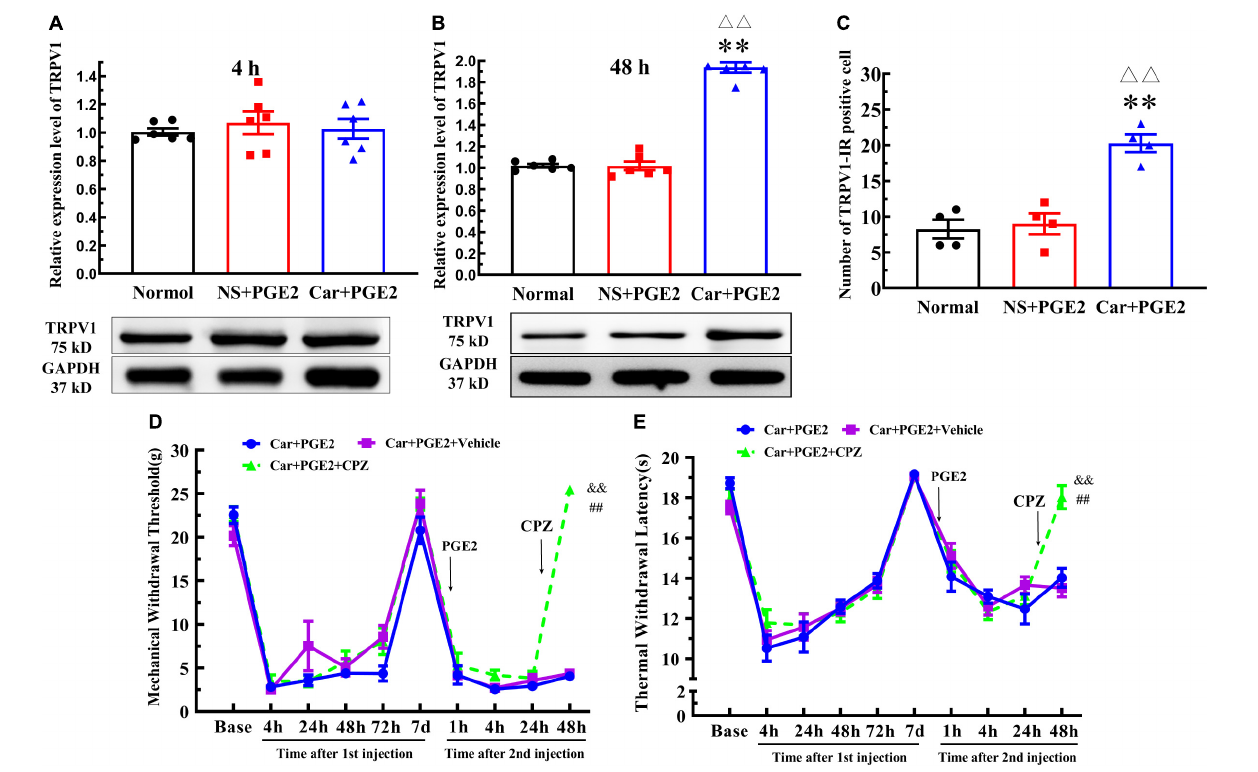
FIGURE 3 | Transient receptor potential vanilloid 1 (TRPV1) in the DRG contributed to the chronic mechanical and thermal pain induced by carrageenan and PGE2 injections. (A) The quantification of the Western blot results and a representative Western blot showing TRPV1 protein isolated from the DRG 4 h after PGE2 injection. (B) The quantification of the Western blot results and a representative Western blot showing TRPV1 protein isolated from the DRG 48 h after PGE2 injection. (C) The quantification of TRPV1–IR positive neurons. Mechanical (D) and thermal (E) responses of hyperalgesia model animals that received capsazepine (CPZ) injection. n = 6. **Compared with the normal group, P < 0.01; (cid:52)(cid:52) compared with the NS+PGE2 group, P < 0.01; ## compared with the Car+PGE2 group, P < 0.01; && compared with the Car+PGE2+vehicle group, P <